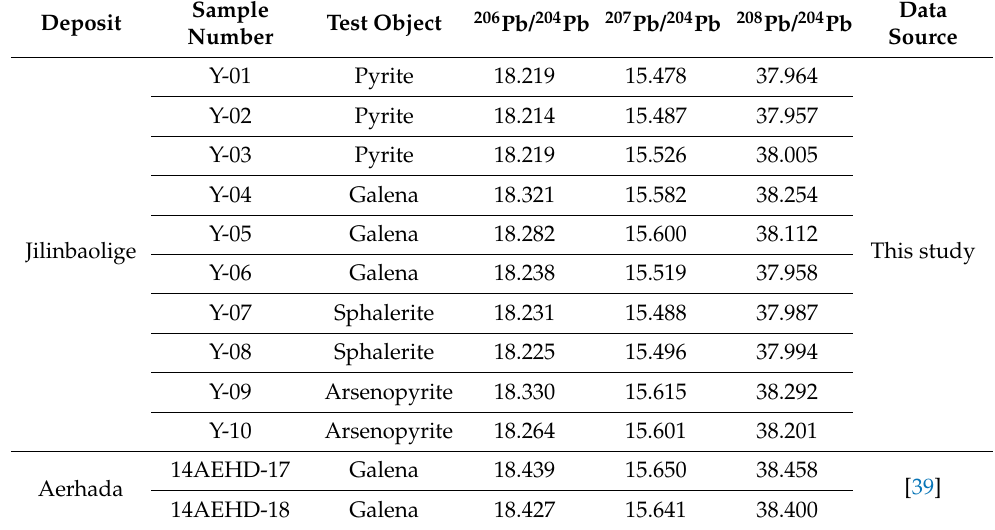
Table 6. Lead isotopic compositions of the sulfides in the Jilinbaolige deposit and the polymetallic deposits in the Great Xing’an